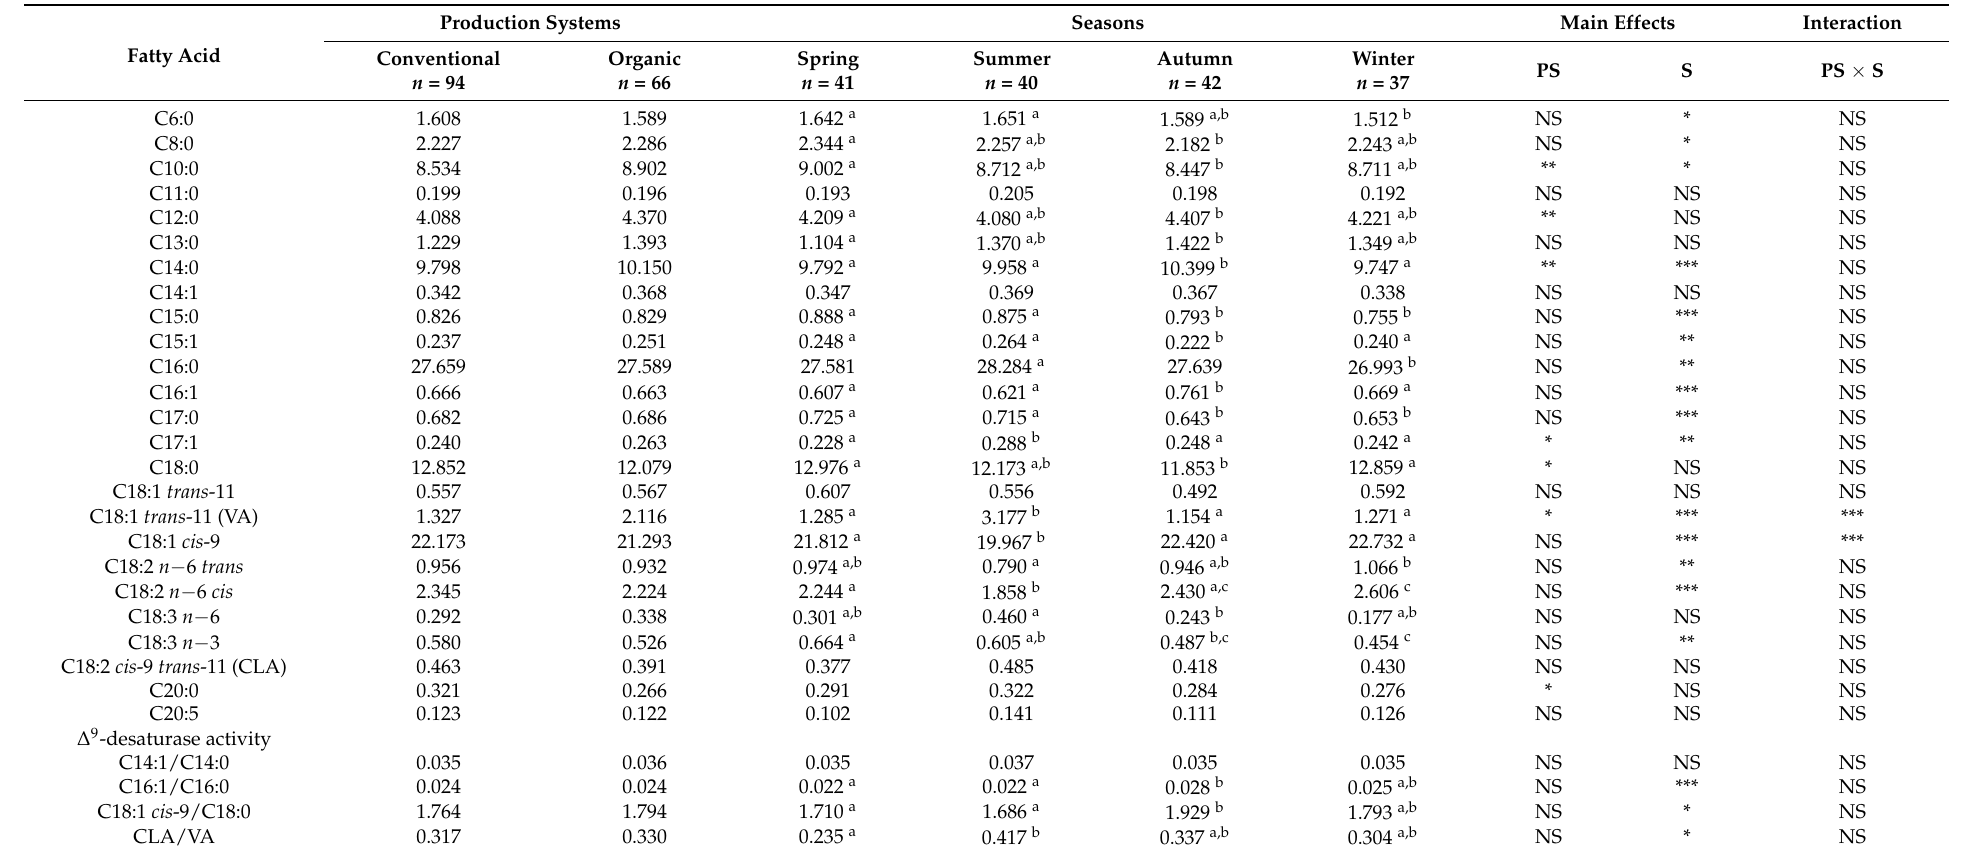
Table 4. Effects of production system and season on milk fatty-acid composition (% of total identified fatty acids) and p - values for the main effects and their